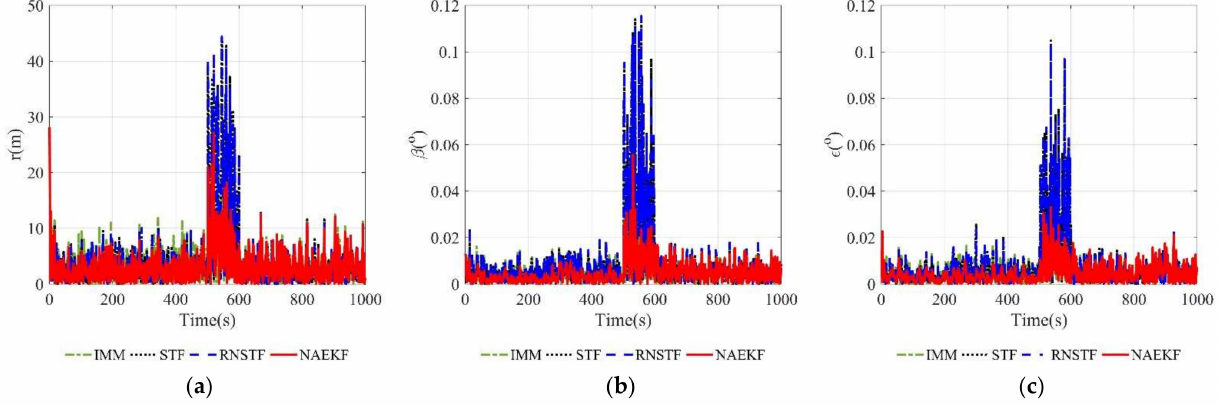
Figure 12. Position estimations errors. ( a ) Estimation errors of the range; ( b ) Estimation errors of the azimuth angle; ( c ) Estimation errors of the elevation angle.